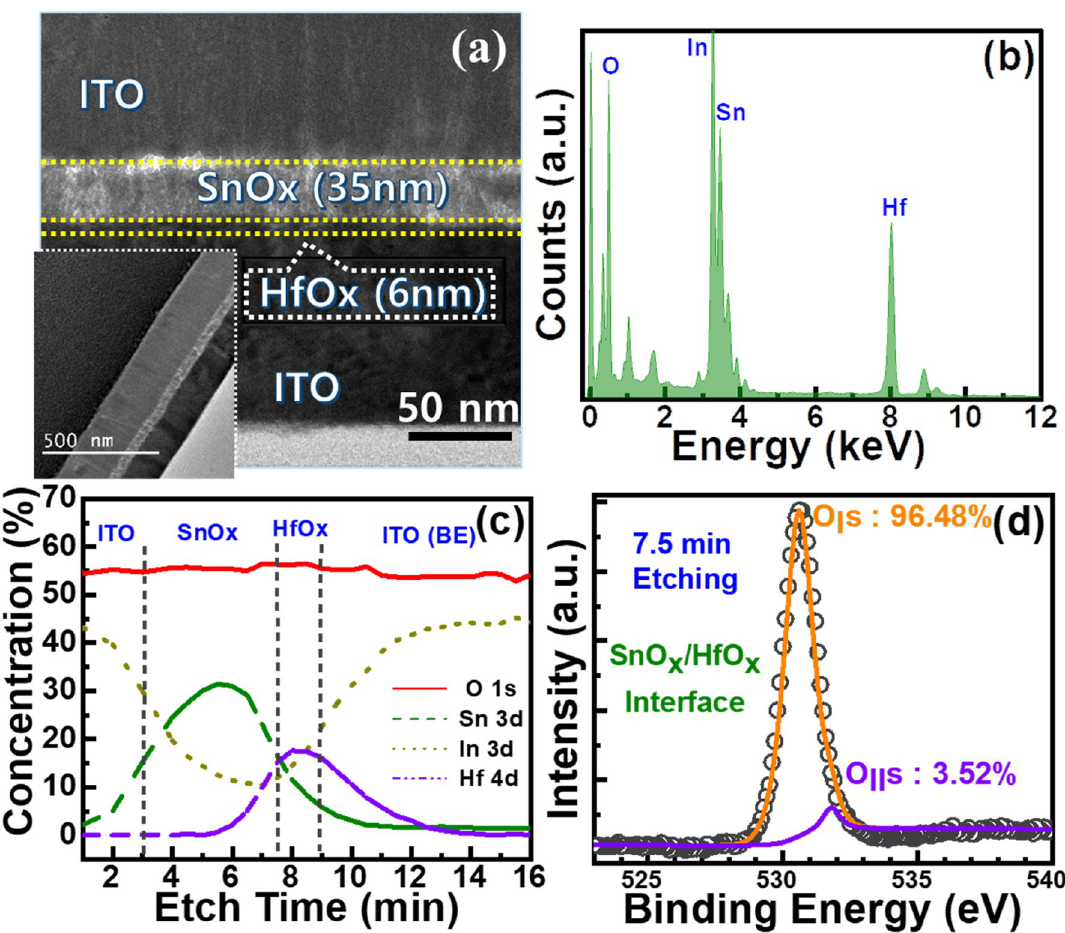
Figure 7. ( a ) TEM cross-section micrograph of the ISHI-1 memristor, inset showing the larger area of the device. ( b ) EDS elemental mapping spectra of the same device. XPS ( c ) depth profile spectra and ( d ) O1s fitting spectrum after 7.5 min etch time at the SnOx/HfOx interface of the